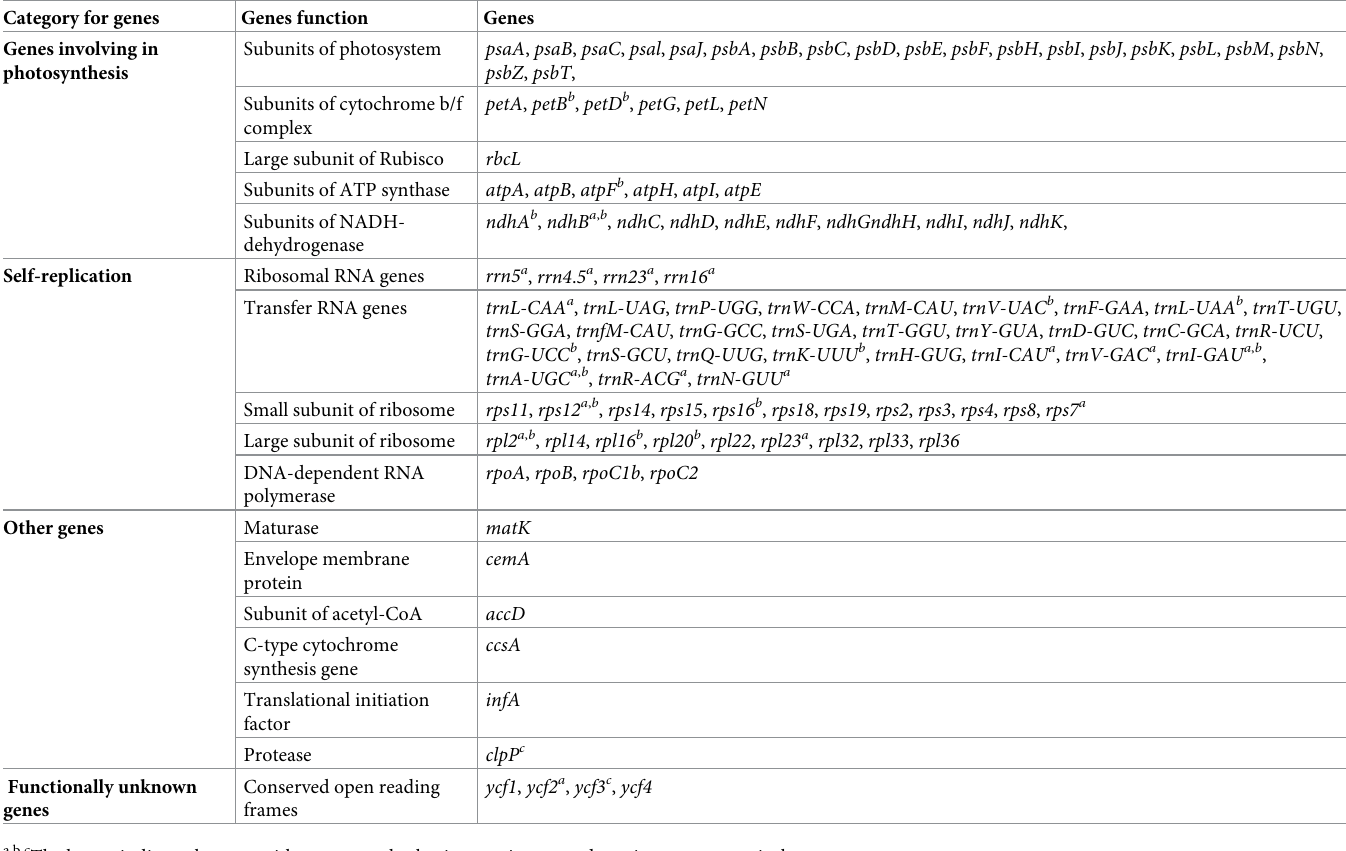
Table 2. Summary of assembled gene functions of Houttuynia cordata Thunb cp genome. Category for genes